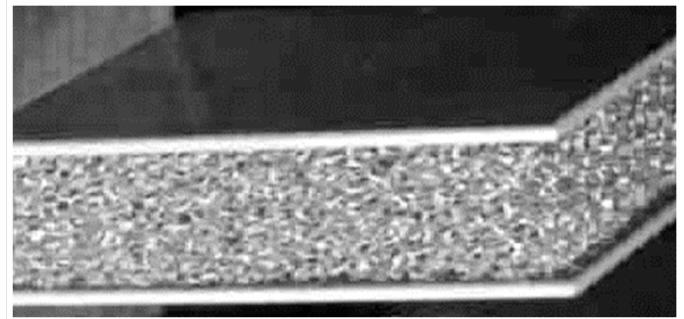
Figure 2. A sample of the metal porous collectors in the presented